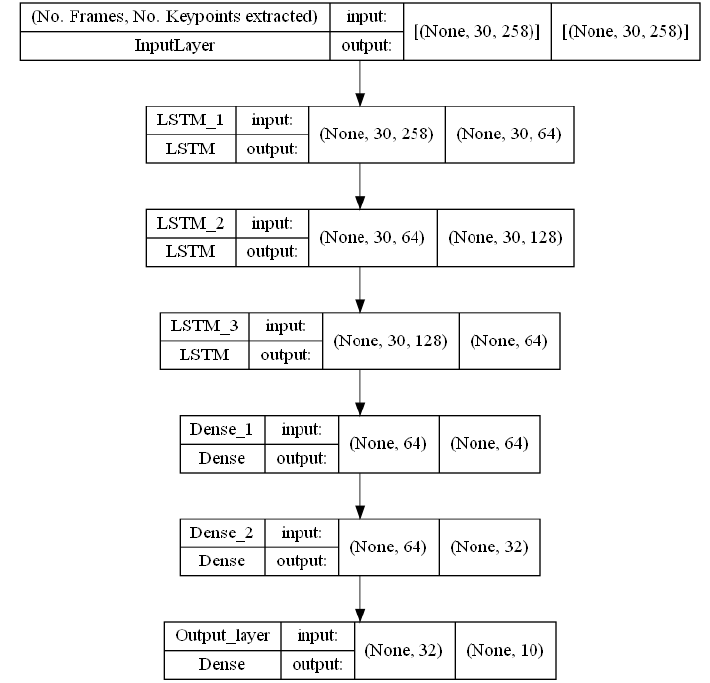
Figure 5. LSTM model structure.